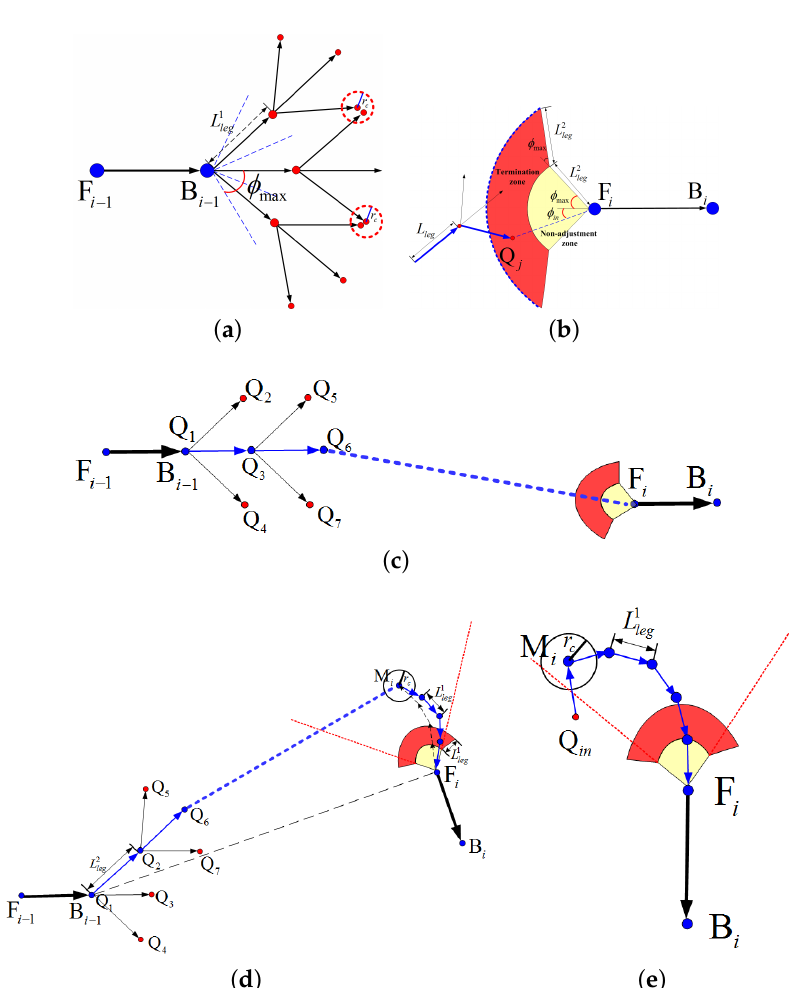
Figure 12. Illustration of the proposed SSAS algorithm. ( a ) the search tree utilized to sample the C-space; ( b ) ring-shaped termination zone used to achieve a smooth approaching to the ending collection segment; ( c ) snapshot of SSAS with small orientation difference between the adjacent collection segments; ( d ) snapshot of SSAS with large orientation difference between the adjacent collection segments; and ( e ) extreme case requiring a